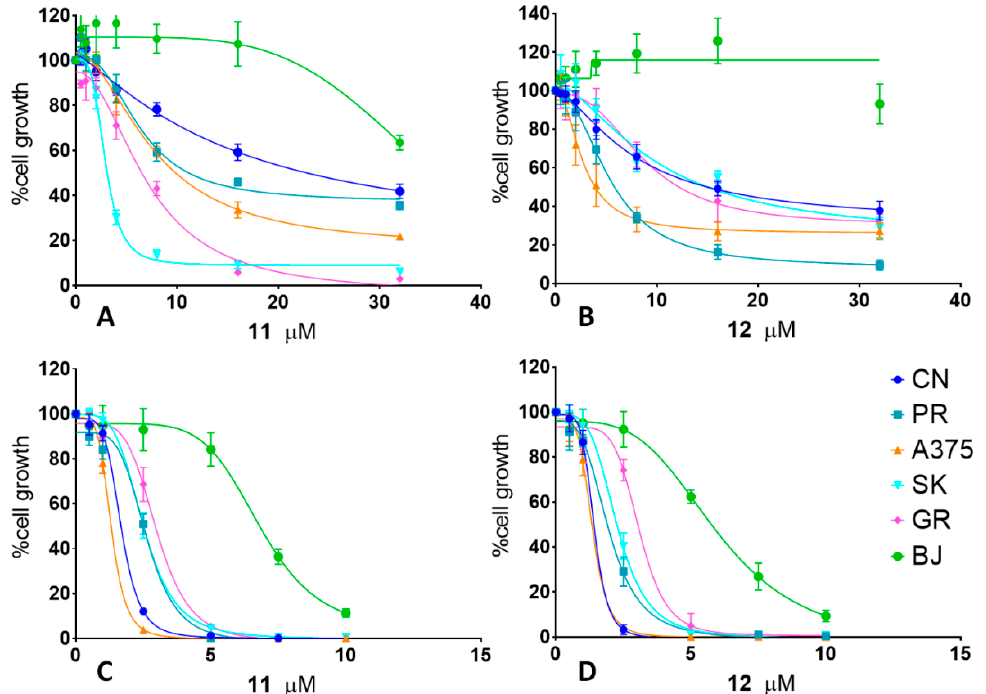
Figure 2. Antiproliferative activity: Cells were cultured with increasing concentrations (0.5–32 μ M) of either 11 ( A , C ) or 12 ( B , D ) up to 24 h ( A , B ) or 72 h ( C , D ). Cell proliferation values were calculated as the growth percentages of treated cells compared to the untreated ones. Graphs represent the curves extrapolated [35] by the nonlinear regression of a variable slope (four parameters), with GraphPad Prism (v. 7.00) for the results of three experiments, each done in triplicate, ± the standard deviation, as described in Materials and Methods.